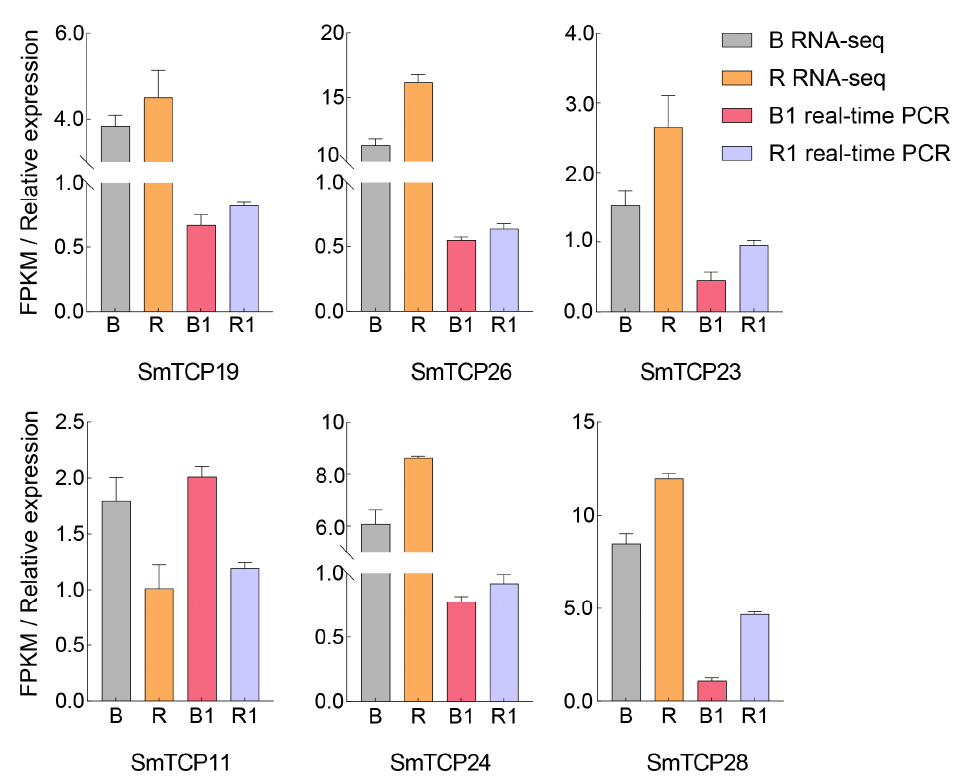
Figure 7. qRT-PCR validation of DETCP transcripts.